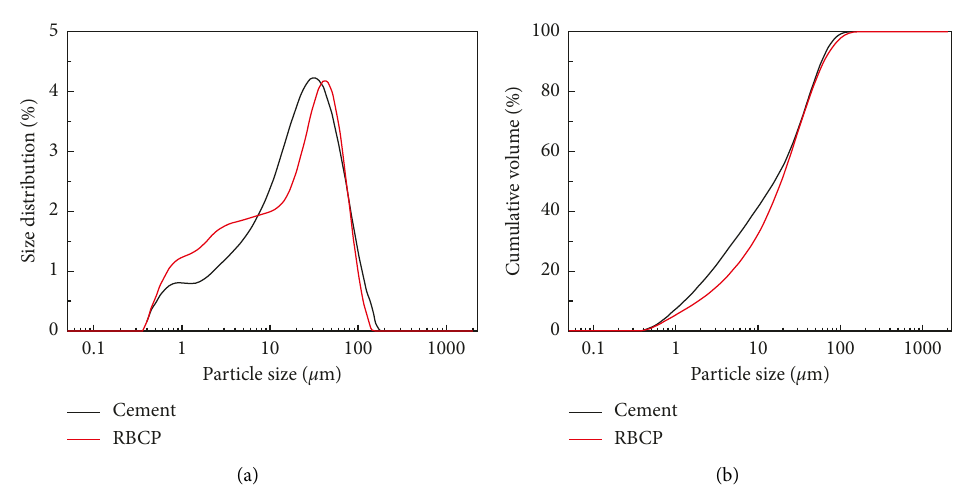
Figure 3: Particle size distribution and cumulative volume of fine